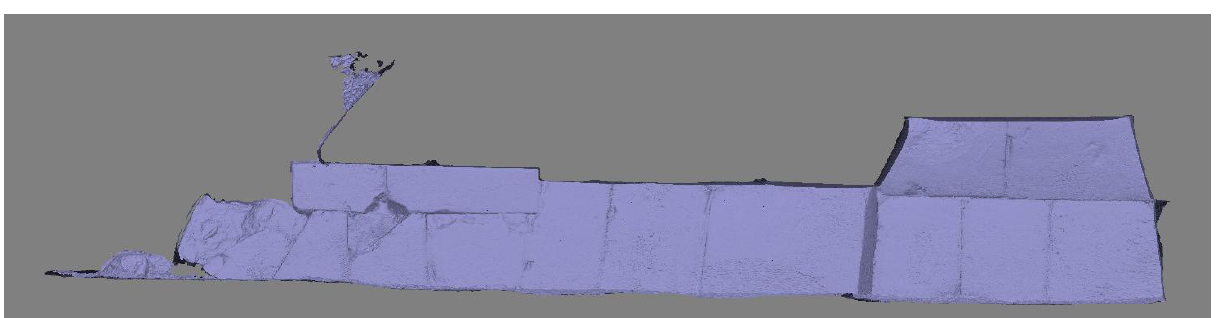
Figure 8. 3D model of the stone chamber in the Bentenzuka burial mound by SfM (Solid).